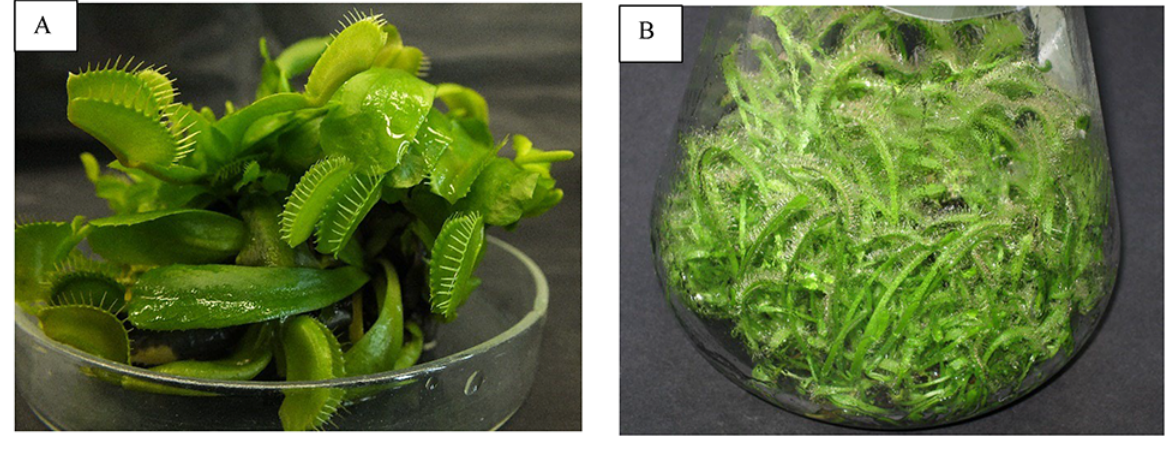
Figure 13 Transformed tissue (teratomas) of carnoivorous plants ( A ) Dionaea muscipula and ( B ) Drosera capensis var. alba